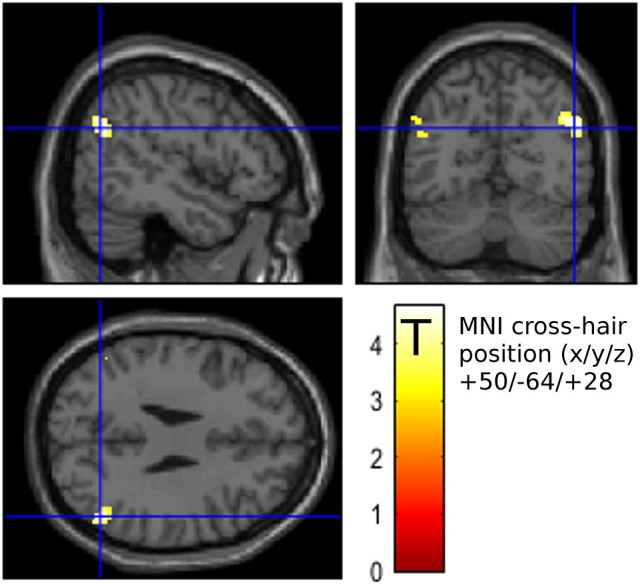
Activation difference (after – before HNMT) yielded stronger effects in chronic (n = 21) compared to recent-onset (n = 21) patients in the mask covering the left and the right angular gyrus (AG) (p < 0.001 uncorrected; 20 voxels extent threshold). The maximum peak was situated in the right AG (crosshairs, neurological view). This cluster peaked in a T score of 4.7 that was significant after FWE correction on cluster level (p < 0.05).